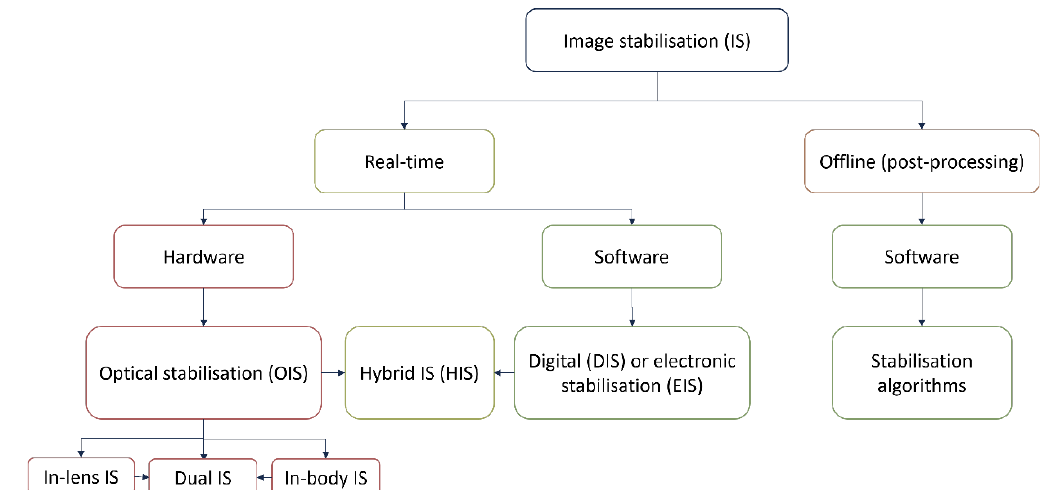
Figure 1 : Image stabilisation techniques.